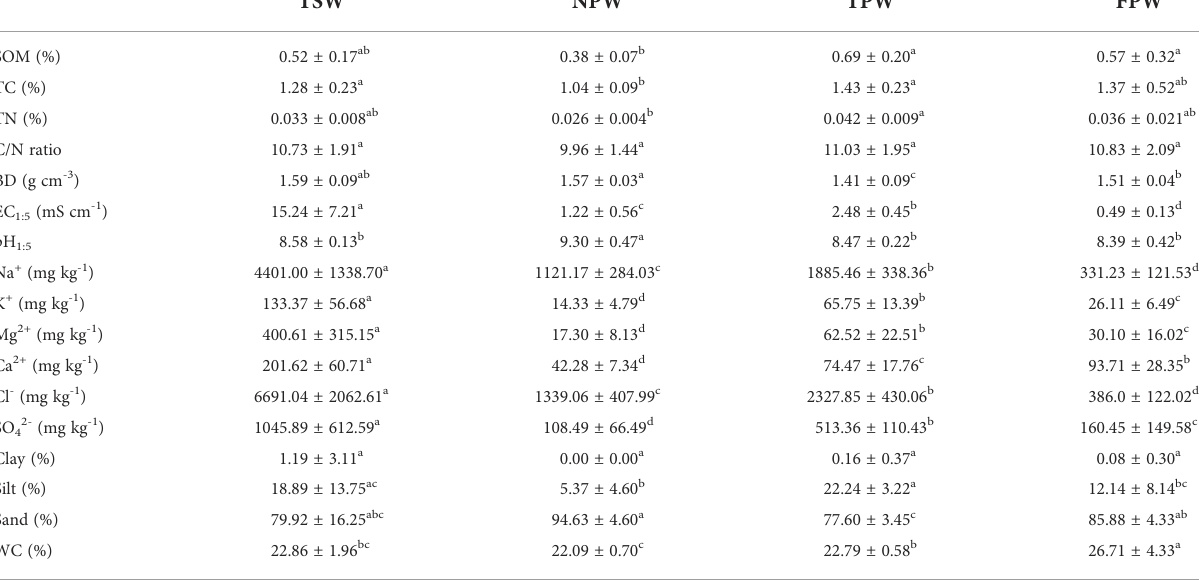
TABLE 1 Soil characterization of 0-25 cm soils in the four